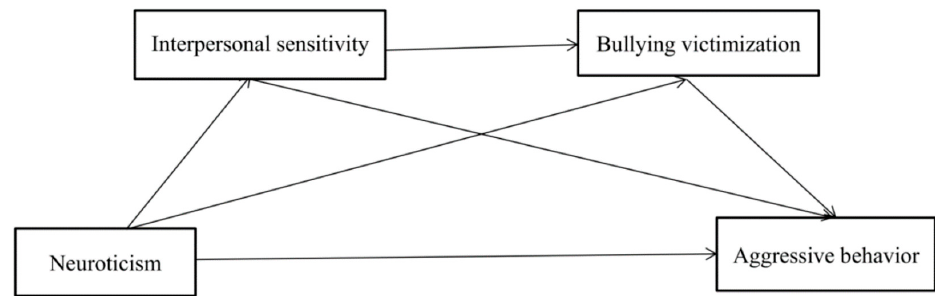
Figure 1. A multiple mediation model of the association between neuroticism and aggressive